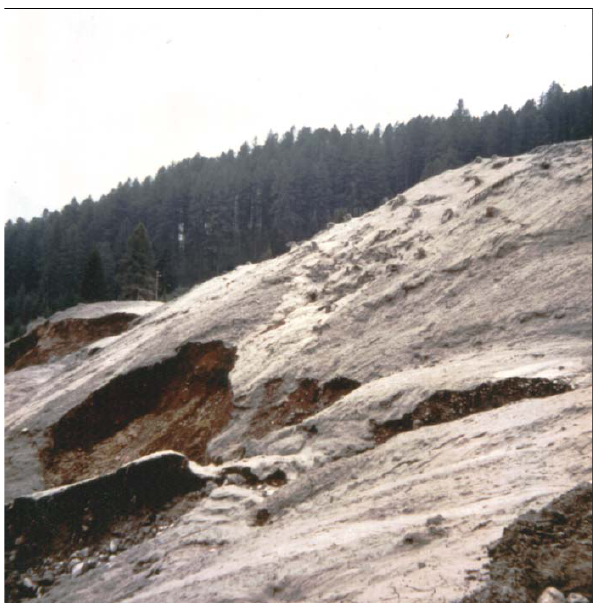
Fig. 11 ‐ Mudflow path of July 19, 1985 along the Stave Valley showing different effects observed by the geologists of CNR ‐ IRPI, Torino during the first surveys. The locations of twenty ‐ two cross ‐ sections measured during the survey are highlighted. The original map base is 1:5.000 scale (from Govi and Luino, 2003, modified).